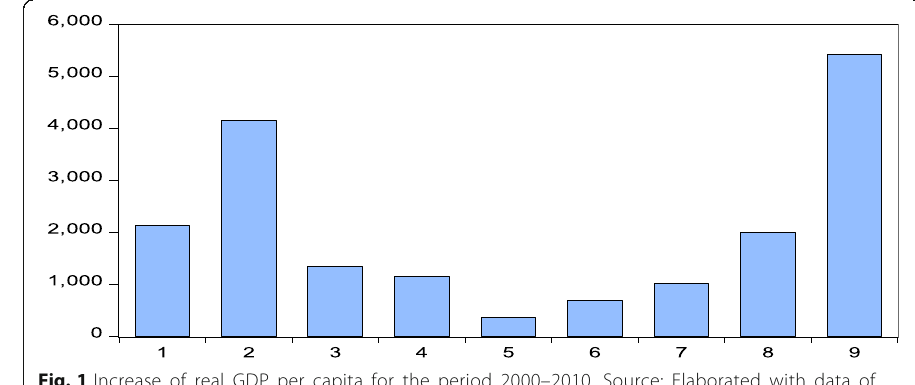
Fig. 1 Increase of real GDP per capita for the period 2000 – 2010. Source: Elaborated with data